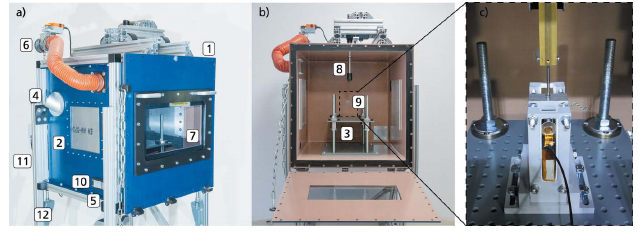
Figure 3 Image of the sample table including the sample holder. The dummy cells are shown in ( a ) a horizontal configuration and ( b ) a vertical configuration. The current setup includes variable positioning of the cell holder, height adjustment of the sample table and different configurable cell holders as well as two different positions for the nail devices: a flexible positioning of the initiation mechanism and high-speed X-ray radiography with cell configurations of up to four cylindrical